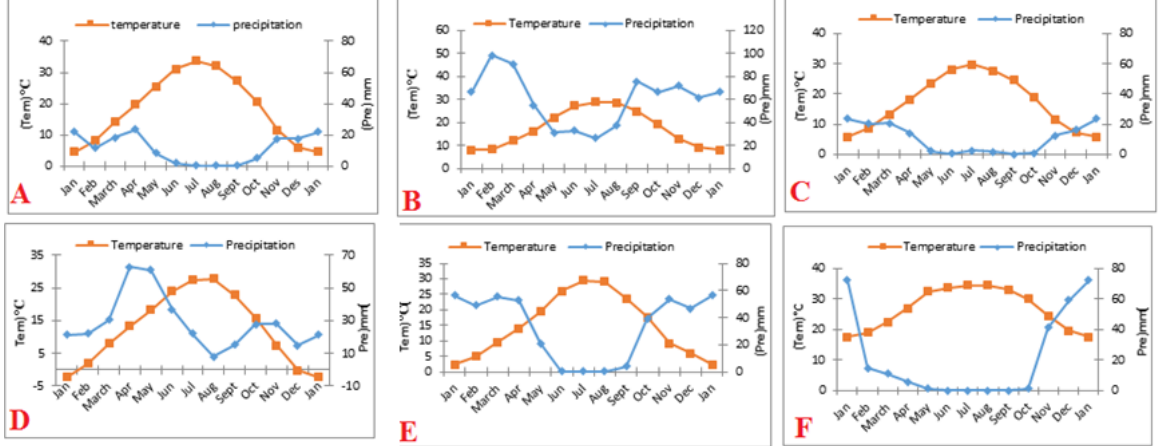
Fig. 4. Embriotermic diagrams: A) Kashan; B) Gorgan; C) Sirjan; D) Khoy; E) Kermanshah; and F)